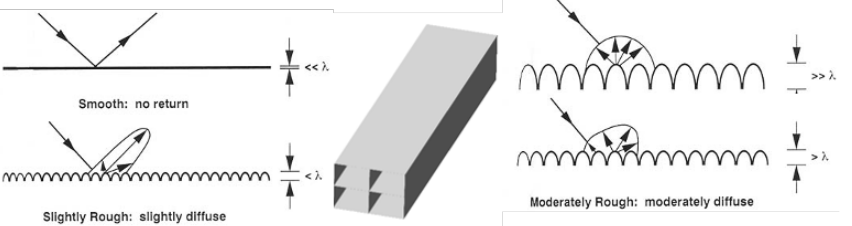
Figure 7. Design of a homogenizer consisting of multi-channels made of scattering surface. Surface roughness effects on light scattering. Surfaces whose roughness is much less than the light wavelength scatter in the specular direction. Rougher surfaces scatter more energy in all directions, including the direction back to the incidence light.